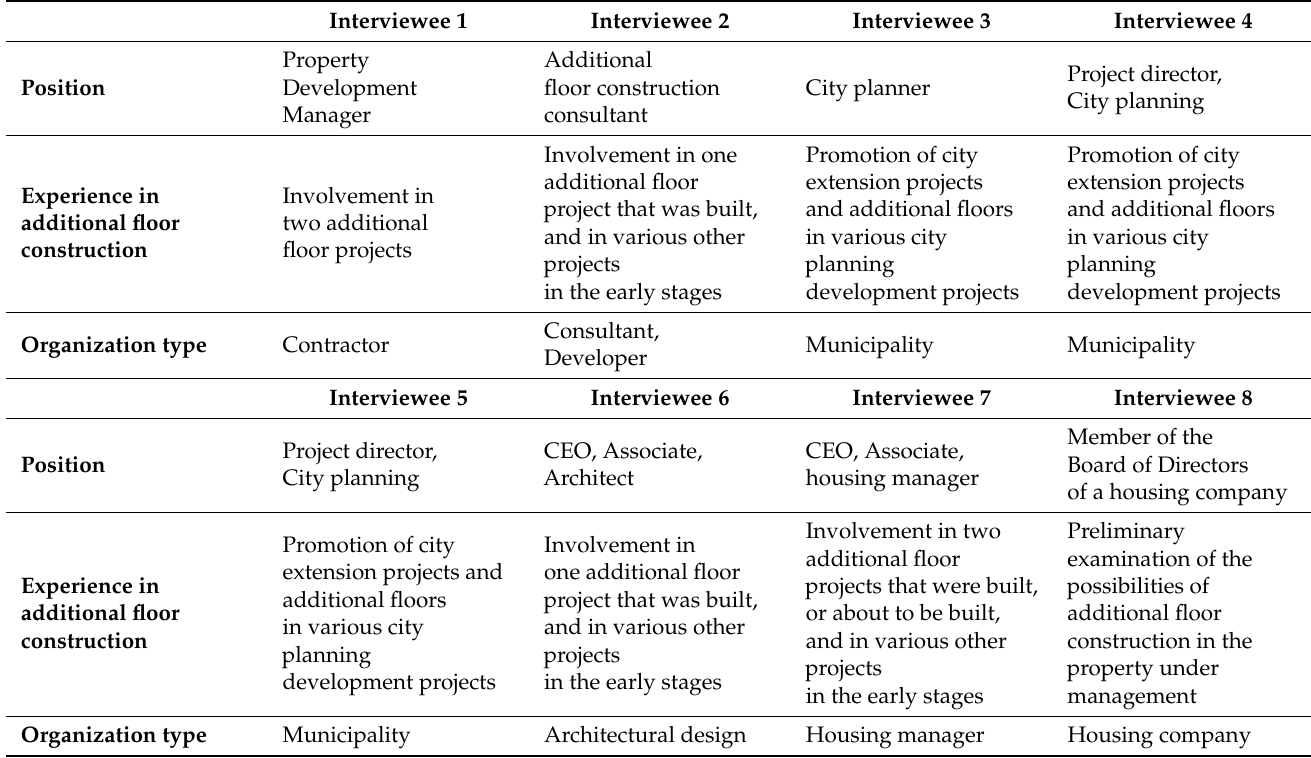
Table 1. Interviewees by their position, experience in additional floor construction, and organization